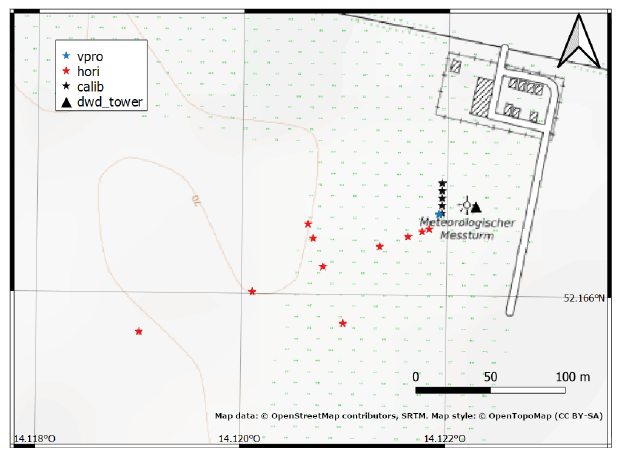
Figure 3. Map of the GM Falkenberg site with the location of measurement points for the different flight patterns (stars) and the meteorological mast (black triangle). Background map data are taken from ©OpenStreetMap contributors, SRTM (map style: ©OpenTopoMap CC